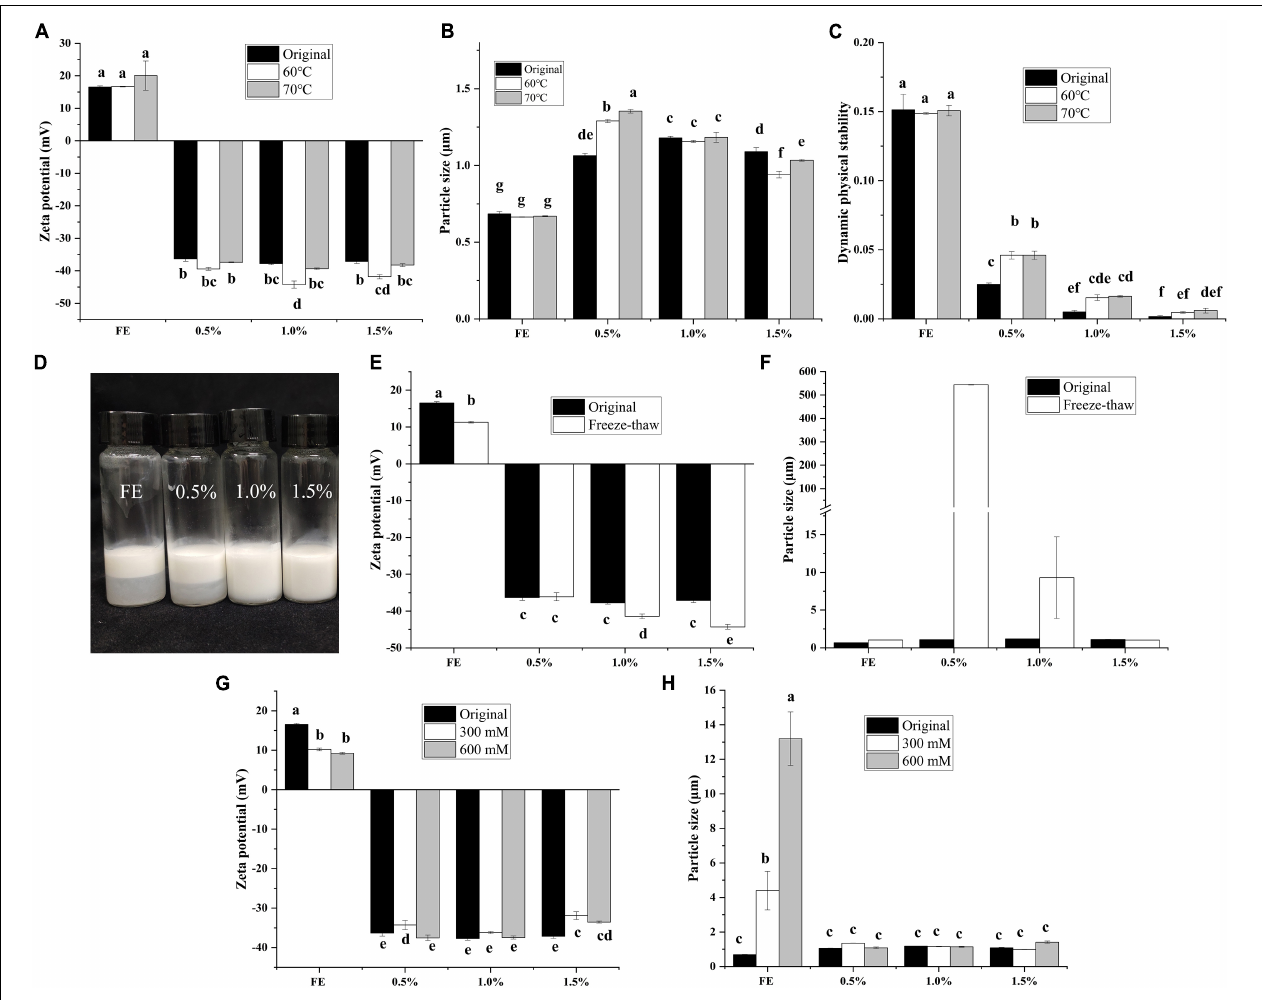
FIGURE 4 | Effect of heat treatment on zeta potential (A) , particle size (B) , and dynamic physical stability (C) of complex emulsions; effect of freeze-thaw treatment on appearance (D) , zeta potential (E) , and particle size (F) of the complex emulsion; effect of freeze-thaw treatment on zeta potential (G) and particle size (H) of complex